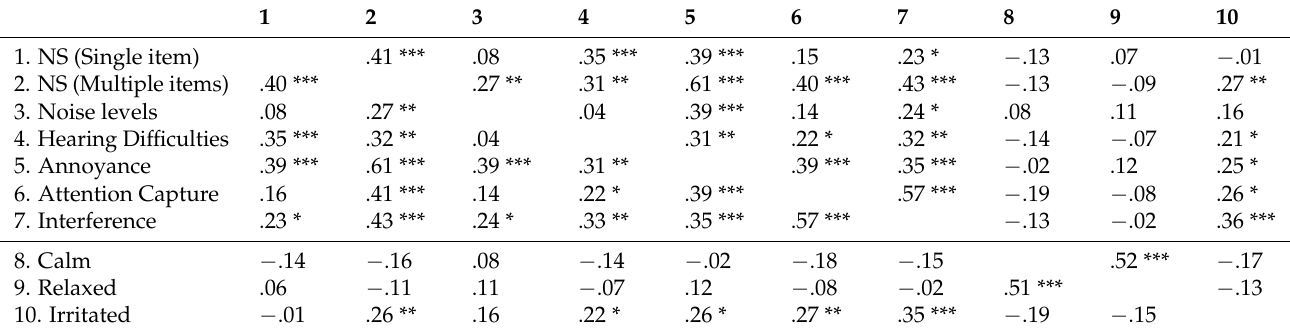
Table 2. Correlations between all the variables used in Study